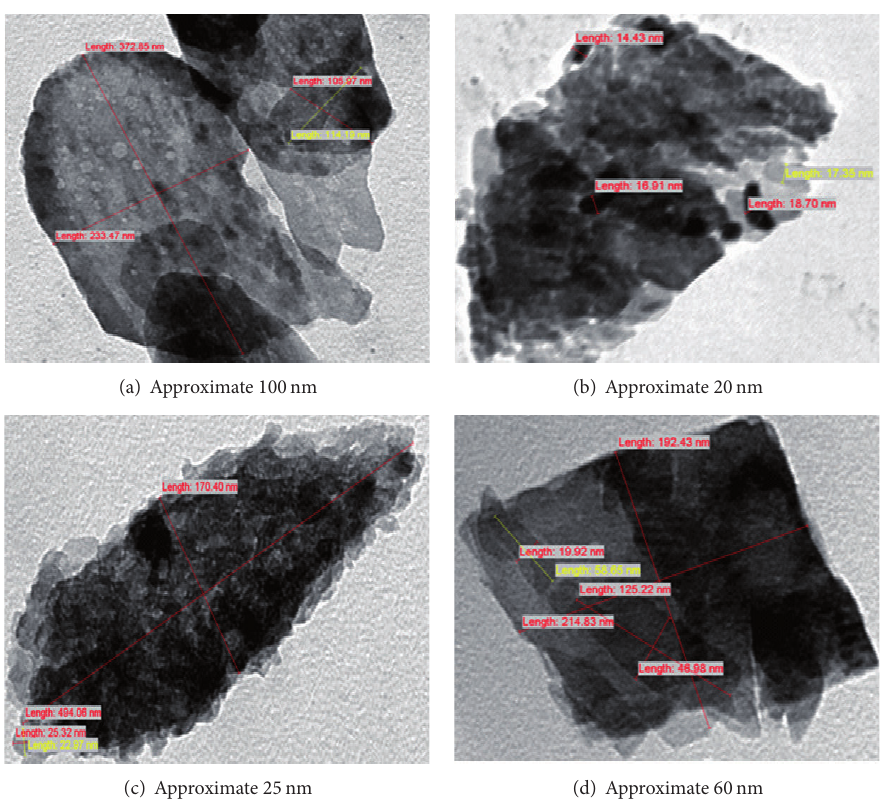
F 4: TEM micrographs of (a) IERC(2Bu-Et), (b) IERC(2Bu-Et)RBi1, (c) IERC(isoBu-Et), and (d) IERC(isoBu).